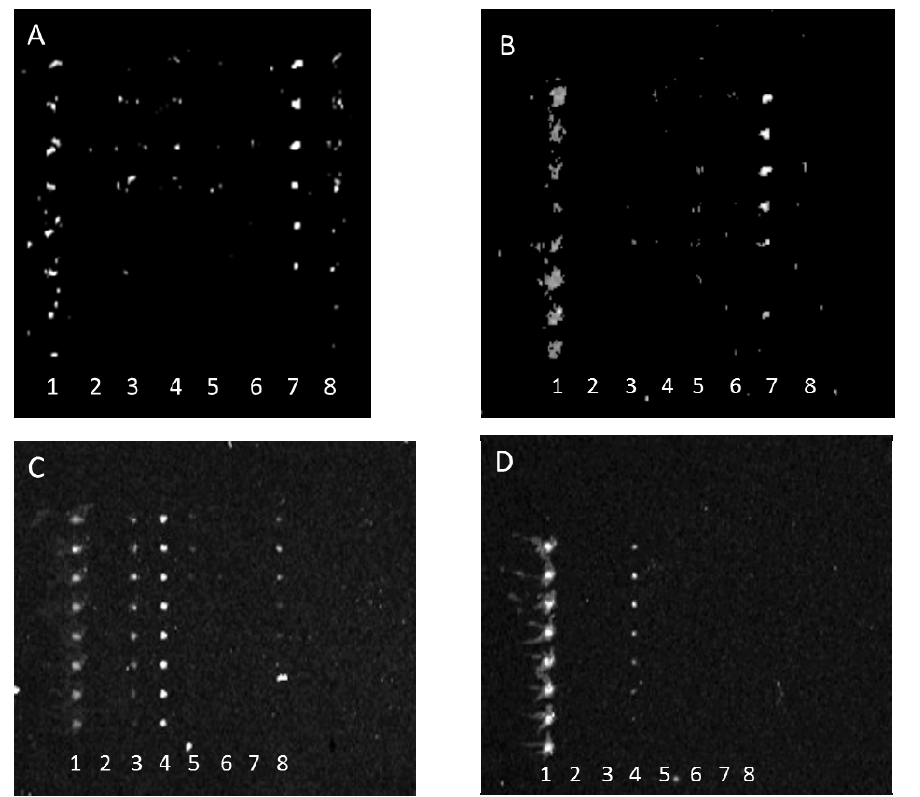
Figure 3. Laser-induced fluorescence scan images of anti-STEC microarrays: Dilution of bacterial target increased specificity of antibody capture in typing microarray. Multiple anti-bacterial capture antibodies were array-printed onto the bottoms of single wells of 96-well microtiter plates. Each column (or lane) within the array was printed with the same antibody, providing 8 replicates. The array was printed as follows: column 1, AF555-labeled antibody marker; columns 2-8, anti-O157, anti-O145, anti-O126, anti-O111, anti-O103, anti-O45, and anti-O26 antibodies, respectively. Samples containing purified bacteria were added to separate, individual wells. After any binding of the bacteria to capture antibody, captured bacteria were visualized via exposure to SYBR Gold and detection with laser-induced fluorescence scanning. Each image, A-D, depicts a single array and reveals the reaction of low dilutions of anti-STEC IgGs with different concentrations of STEC cells: PSU IgGs (diluted 1:10) with E. coli O45 at concentrations of ca. 1 × 10 8 CFU/mL ( A ) and ca. 1 × 10 7 CFU/mL ( B ) and KPL IgGs (diluted 1:30) reacted with E. coli O121 at concentrations of ca. 1 × 10 8 CFU/mL ( C ) and ca. 1 × 10 7 CFU/mL ( D